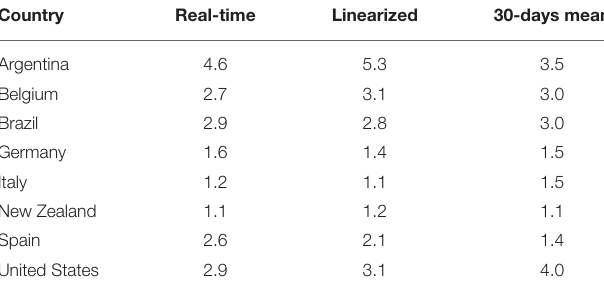
TABLE 3 | R 0 estimates (on/up to May 23,